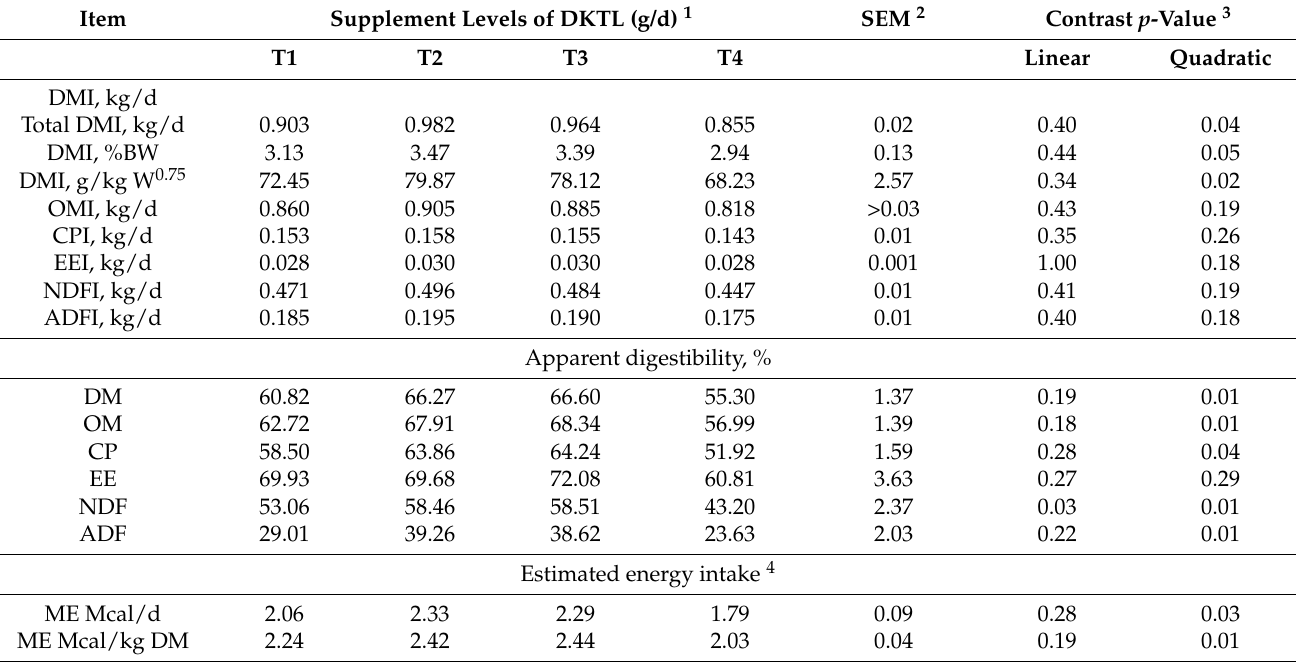
Table 4. Effects of supplement levels (g/d) of dried kratom leaves on feed intake, nutrient intake, and apparent digestibility of nutrients in goats.